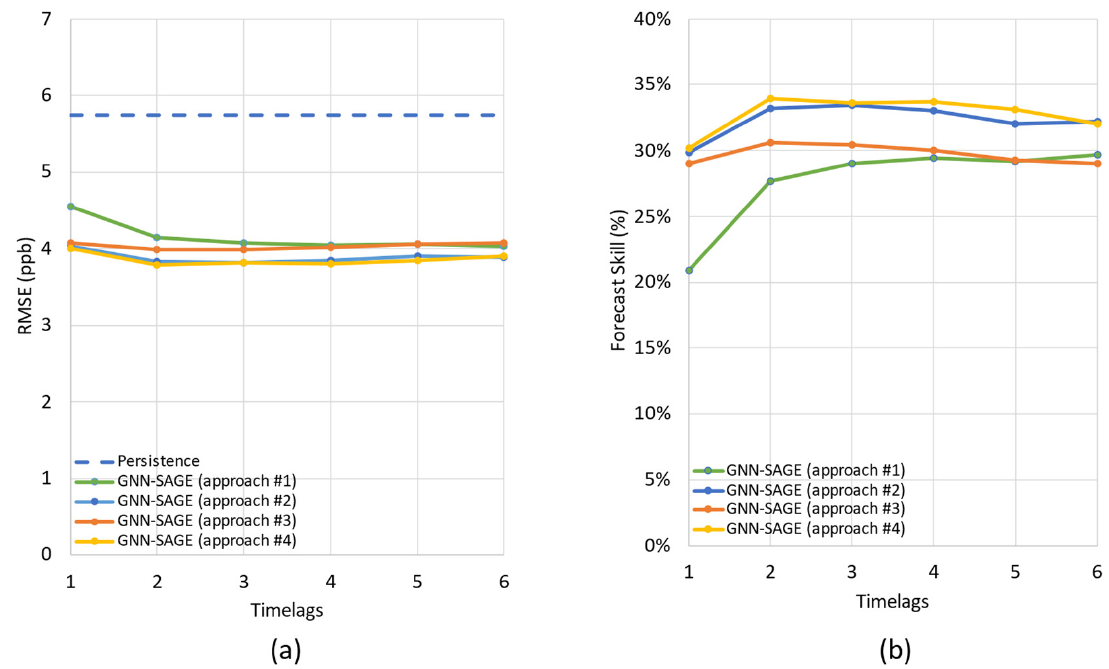
Figure 6. Effect of different number of time-lags on the model’s prediction for 1 h forecast horizon in terms of RMSE ( a ) and Forecast Skill ( b ).